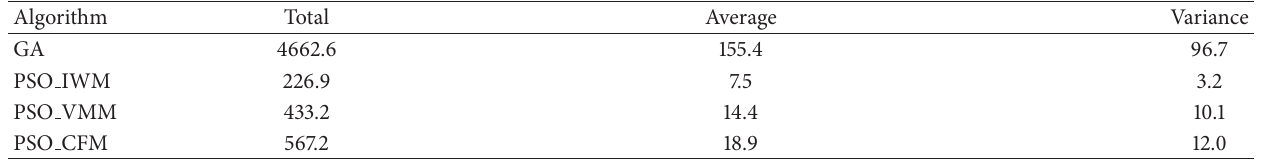
Table 8: ANOVA verification of convergence time.